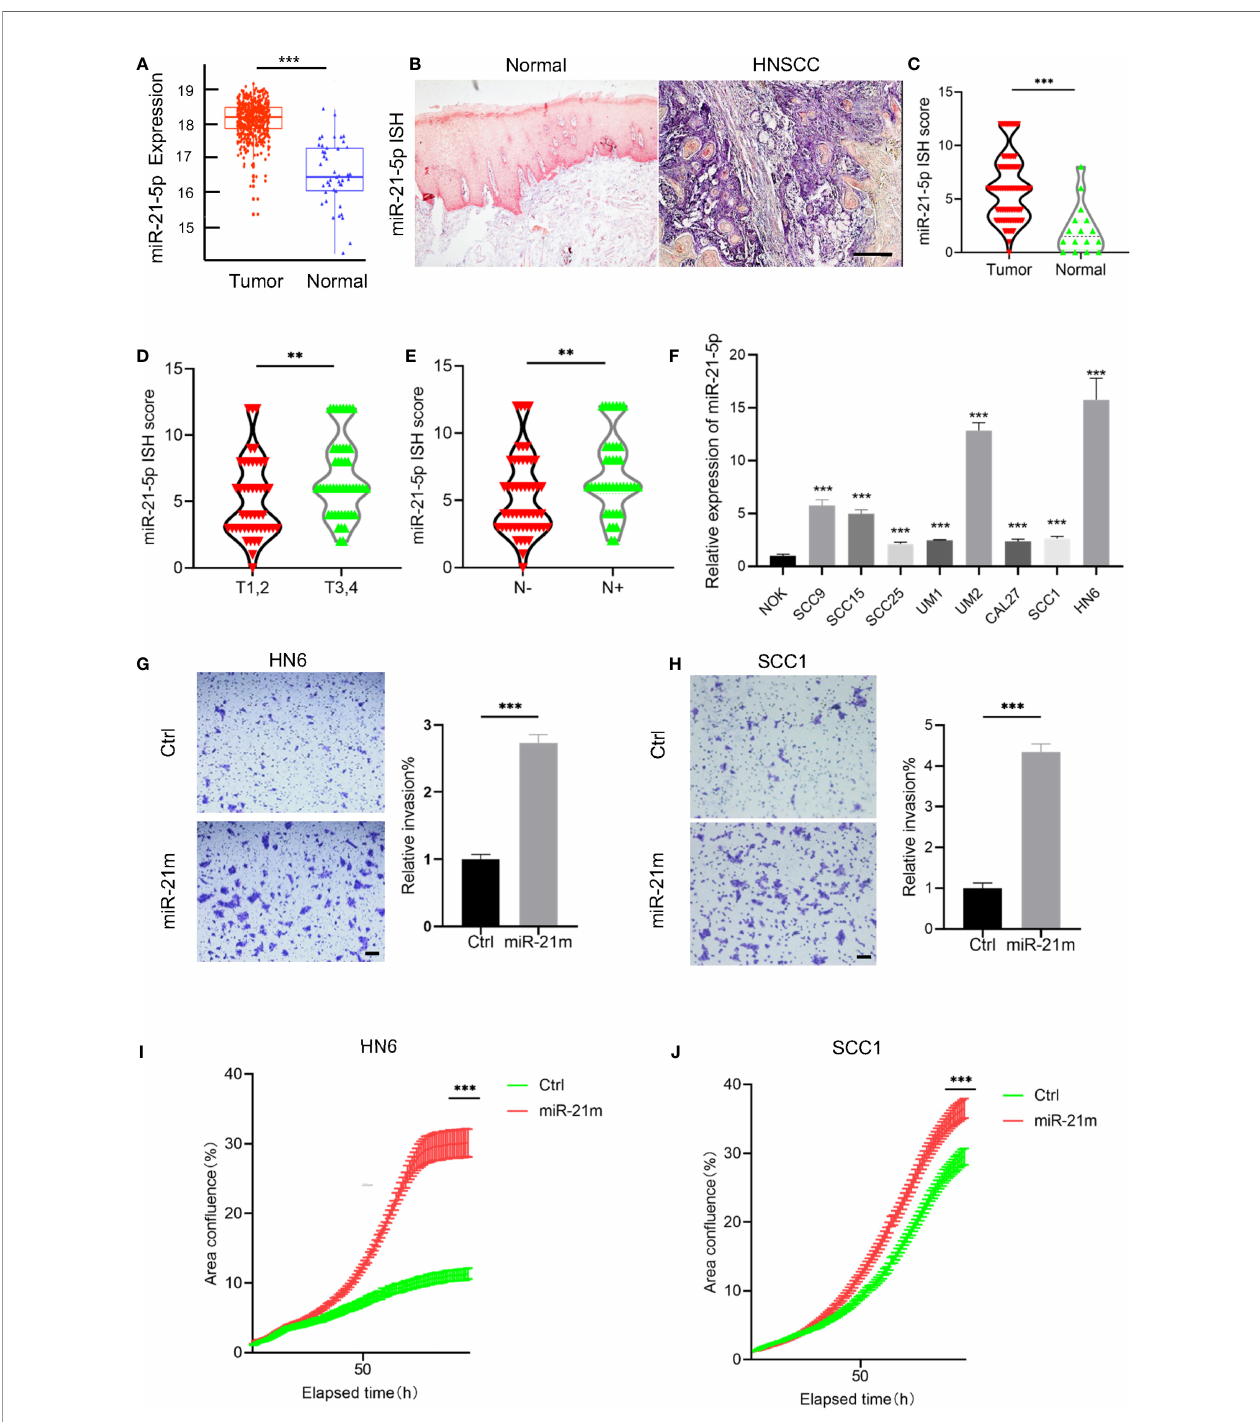
FIGURE 1 | The expression of miR-21-5p was upregulated and correlated with malignant progression in HNSCC. (A) The expression of miR-21-5p was upregulated in HNSCC as compared to the normal tissue. Data was from TCGA HNSCC datasets downloaded using the UCSC Xena browser (https://xenabrowser. net). ***P < 0.001. (B) The representative images of miR-21-5p ISH staining. Scale bar, 300 m m (C) The quantitative analysis of miR-21-5p ISH staining in HNSCC patient samples. ***P< 0.001 by Student ’ s t-test (D) The expression of miR-21-5p was increased in T3,4 stage HNSCC patient as comparted to those with T1,2 stage. **P < 0.01 by Student ’ s t-test (E) The expression of miR-21-5p was increased in HNSCC patient with lymph node metastasis as comparted to those without lymph node metastasis. **P < 0.01 by Student ’ s t-test (F) The relative of miR-21-5p was upregulated in 8 HNSCC cell lines as compared to NOK cells. ***P < 0.001 by Student t-test. (G, H) Overexpression of miR-21-5p promotes cell invasion of SCC1 and HN6 cells. ***P < 0.001 by Student ’ s t-test. Scale bar, 200 m m (I, J) Overexpression of miR-21-5p promotes proliferation of SCC1 and HN6 cells. ***P < 0.001 by two-way